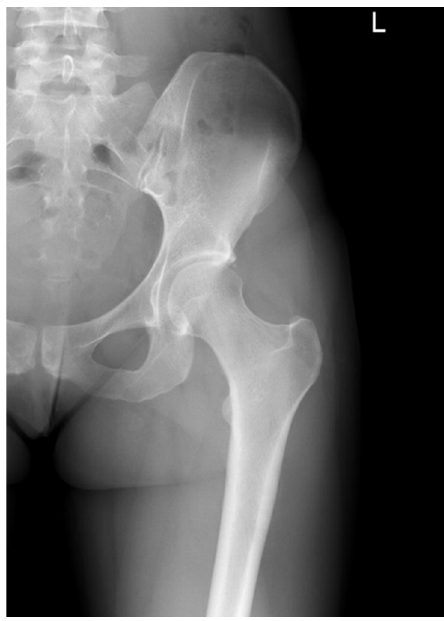
Figure 1. X-ray of the left hip (AP view), performed one month after the onset of the symptoms, which shows no signs of fracture.